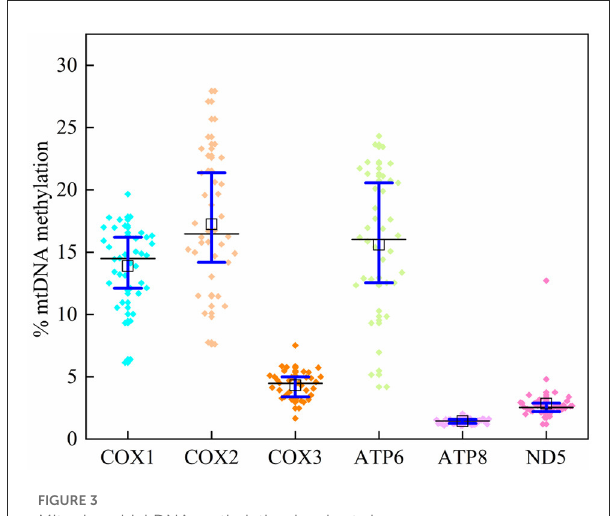
FIGURE3 Mitochondrial DNA methylation levels at six genes.